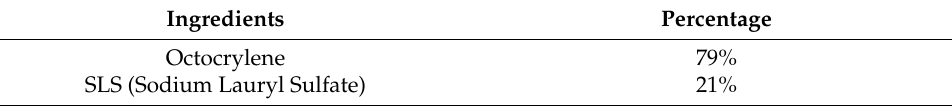
Table 4. Formula TO ACTIVE—Best two ingredients.